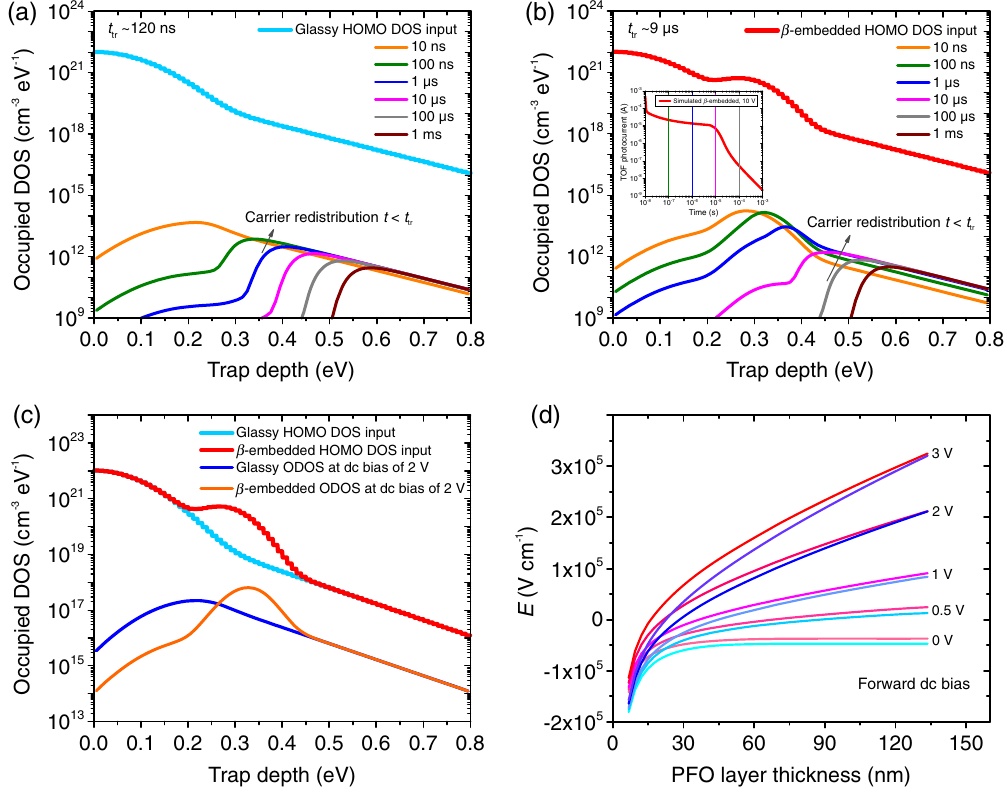
FIG. 12. Plots of the simulated occupied density of states (ODOS) at a point in close proximity (at the 5th out of a total 50 mesh points) ¼ 10 and to the front anode of a TOF device at logarithmically spaced times after laser excitation for (a) a glassy PFO device with V bias ∼ 120 ns and (b) a β -phase embedded PFO device with V ¼ 10 and t ∼ 9 μ s. The inset shows the modeled hole photocurrent t tr bias tr transient (red curve). Colored vertical lines in the inset mark the times following laser excitation, in accordance with the figure legend. The arrows in subplots (a) and (b) denote carrier redistribution into deep states that occurs in the pretransit regime (when t < t ). (c) tr ODOS of glassy and β -phase embedded PFO hole-only devices modeled at a forward dc bias of 2 Vat the midpoint along the active layer thickness. The thick, piecewise-constant functions in subplots (a), (b), and (c) represent numerical hole DOS for glassy (sky blue) and β -phase embedded (red) PFO. (d) Simulated electrostatic field profiles across the glassy (blue-color sets) and β -embedded (red-colour sets) PFO active layers in hole-only devices under a range of forward dc